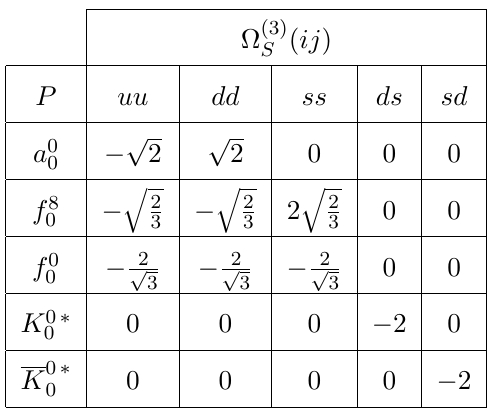
Table 10 . Factor Ω (3)